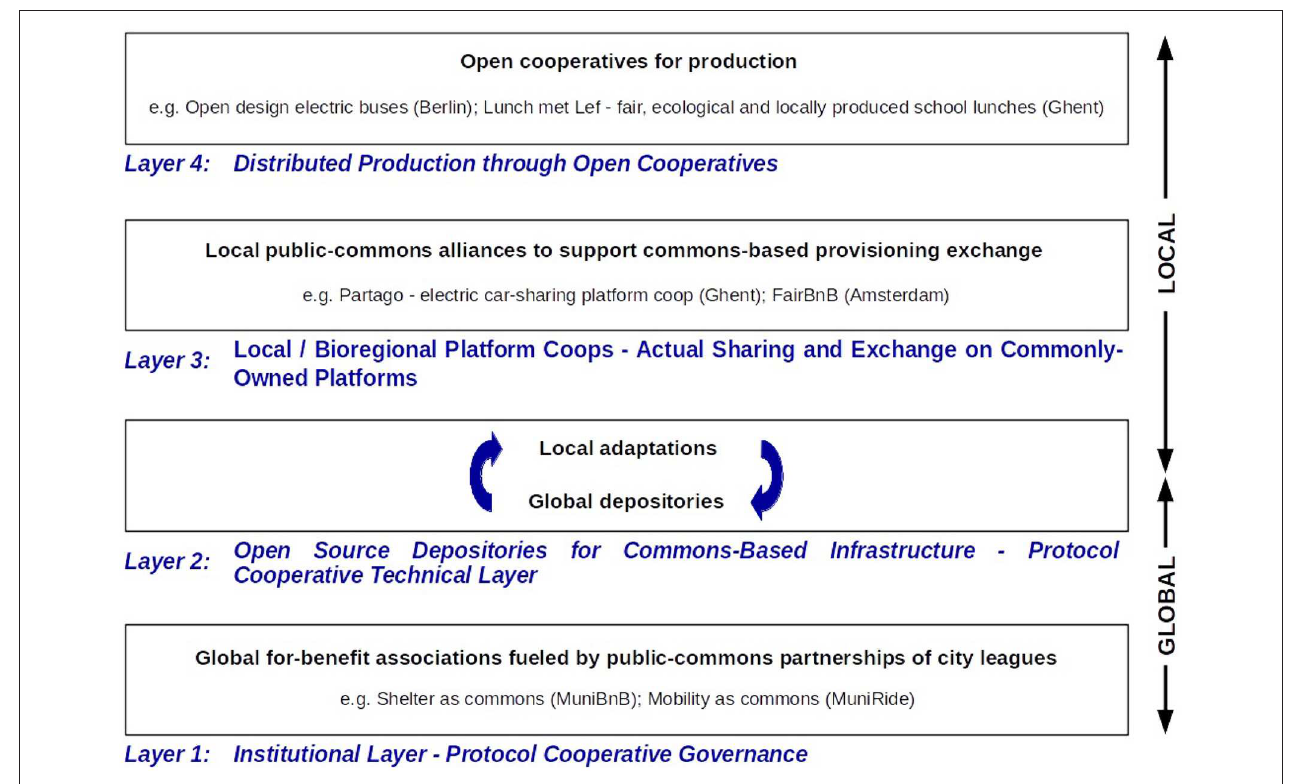
FIGURE 3 | City-supported cosmo-local production infrastructure (used with permission. Graphic by Michel Bauwens. City-supported cosmo-local production infrastructure Previously published in: P2P Accounting for Planetary Survival. By Michel Bauwens and Alex Pazaitis. P2P Foundation, 2019). from local organic farmers in the bioregion of Ghent, using a zero-carbon transportation system of cargo bikes, and create employment for local schools. Copenhagen has achieved 94% of organic food for its students of public